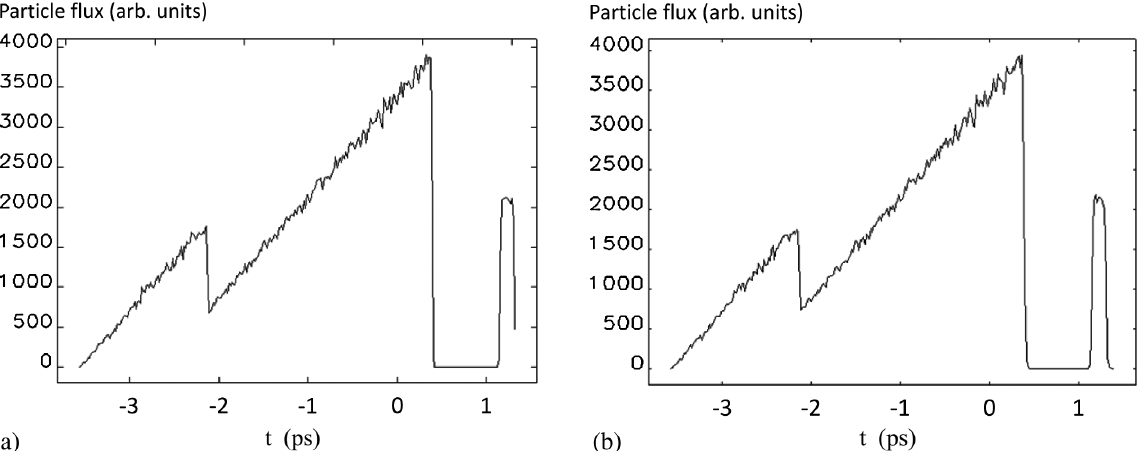
FIG. 7. Output beam in the line with sextupole correctors. Computation with a transfer matrix method accounting for the second-order (a) and up to the third-order (b)